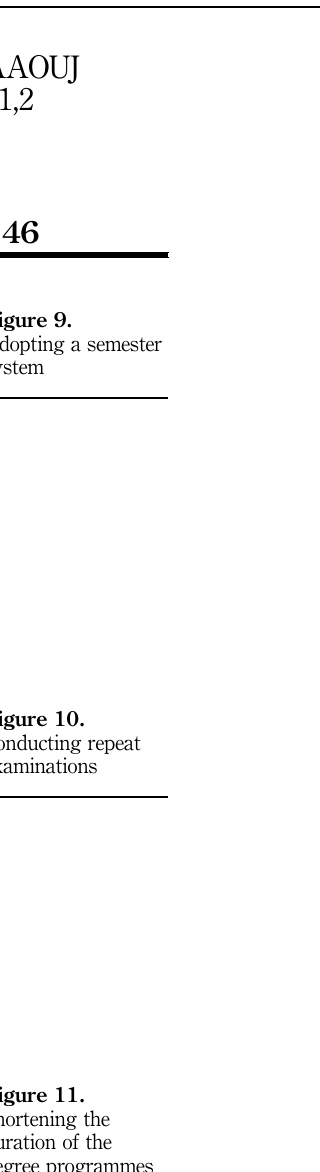
Figure 11. Shortening the duration of the degree